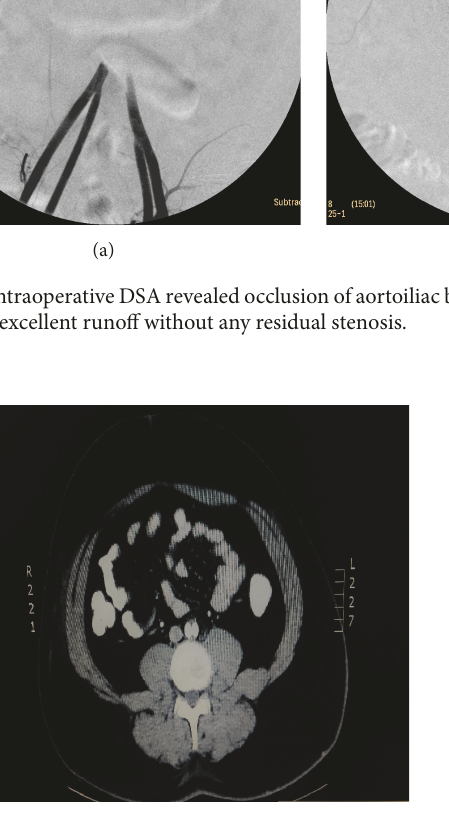
Figure 4: CT aortography depicted excellent patency of covered stents after 1